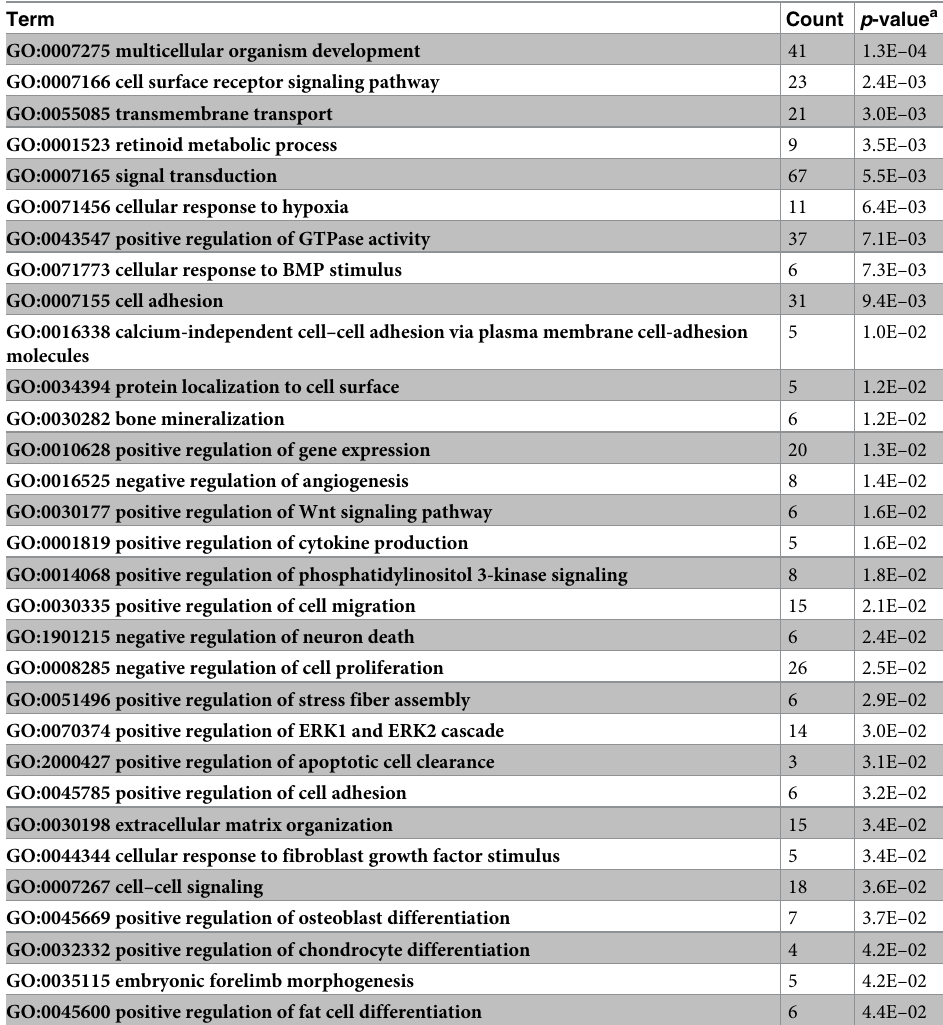
Table 1. Functional analysis of the 697 genes upregulated more than two-fold by NTP using DAVID vir6.8 func- tional annotation tool. Term Count p -value